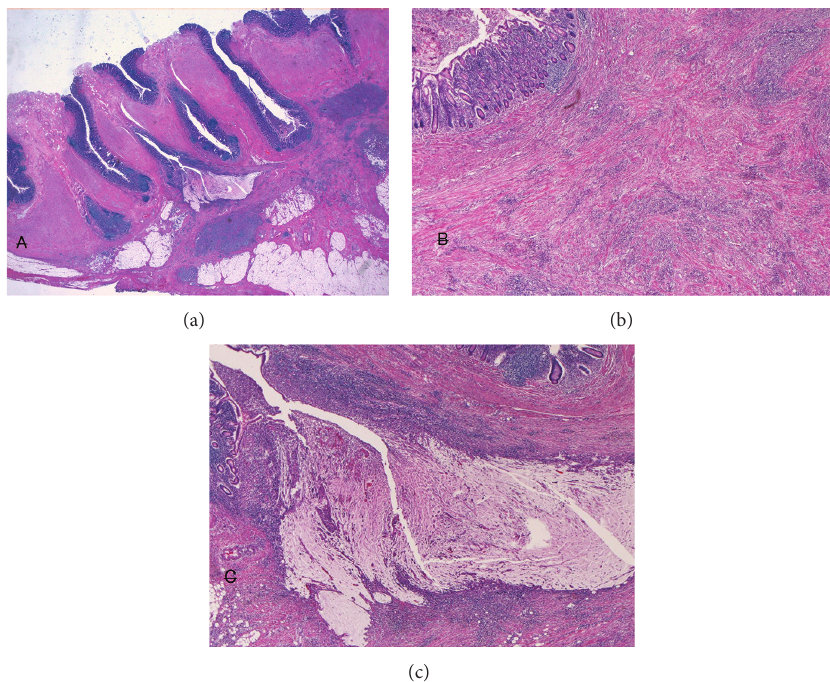
Figure 4: (a) Low power features of appendiceal diverticula. Many diverticula are seen in this section. The diverticula penetrate the muscular layer, suggesting that they are congenital in origin. Much fibrosis and inflammation are seen in the subserosal walls which contain a very thin muscle layer. HE × 5. (b) High power view shows luminal abscess and much fibrosis and lymphocytic infiltration of the subserosa. HE × 50. (c) High power view shows diverticula with penetration. HE ×